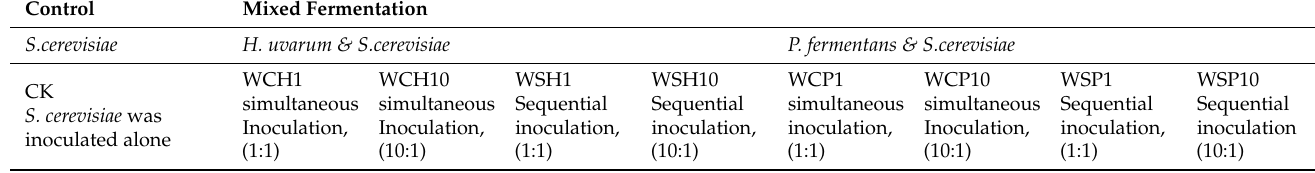
Table 3. Yeast inoculation